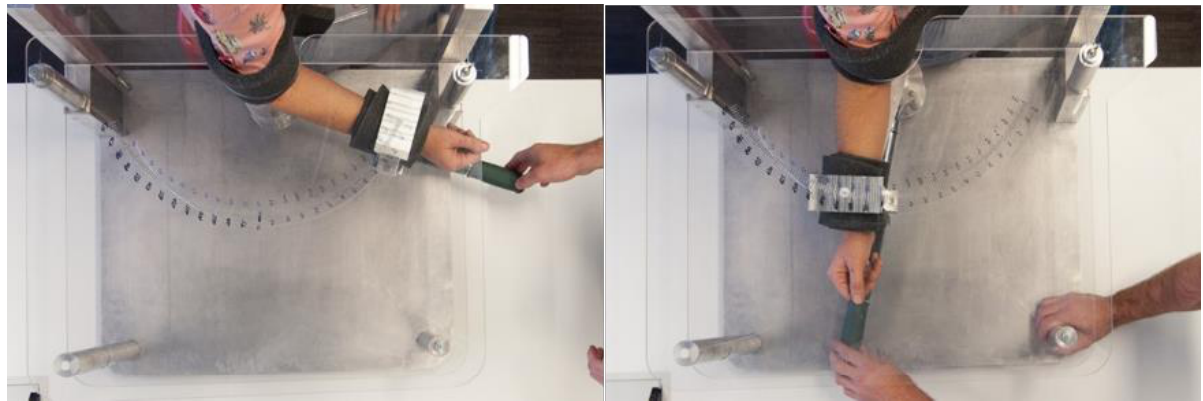
Figure 3. Measurement of the external rotation of one of the subjects in the control group using the measurement device.